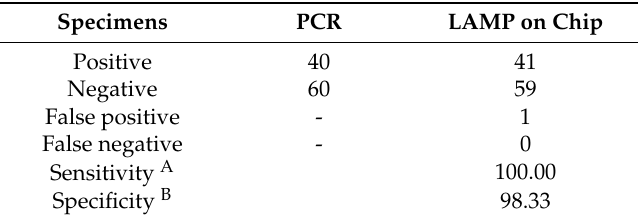
Table 3. Comparison of PCR with LAMP on-chip